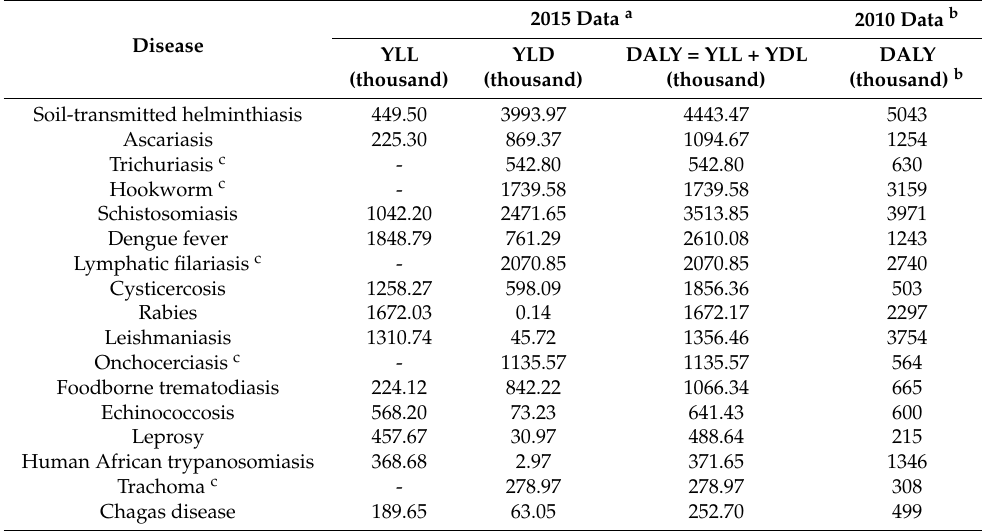
Figure 1. Prevalence of neglected tropical diseases (NTDs) by country. The burden of NTDs in different countries is expressed as number of NTDs prevalent (ranging from one to seven or more). Modified from: United to Combat. Burden map—Neglected Tropical Diseases [74]. Table 2. Global Burden of Major Neglected Tropical Diseases as Estimates of Disability-Adjusted Life Years (DALYs), Years of Life Lost (YLL), and Years Lost Due to Disability (YLD) in WHO Member States.